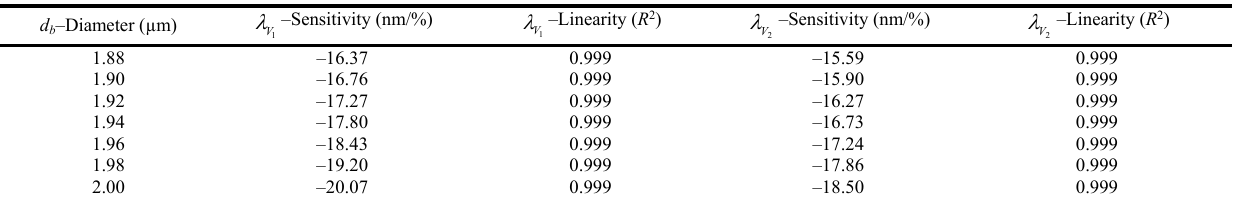
Table 2 Influence of d b on the sensitivity of proposed sensor.